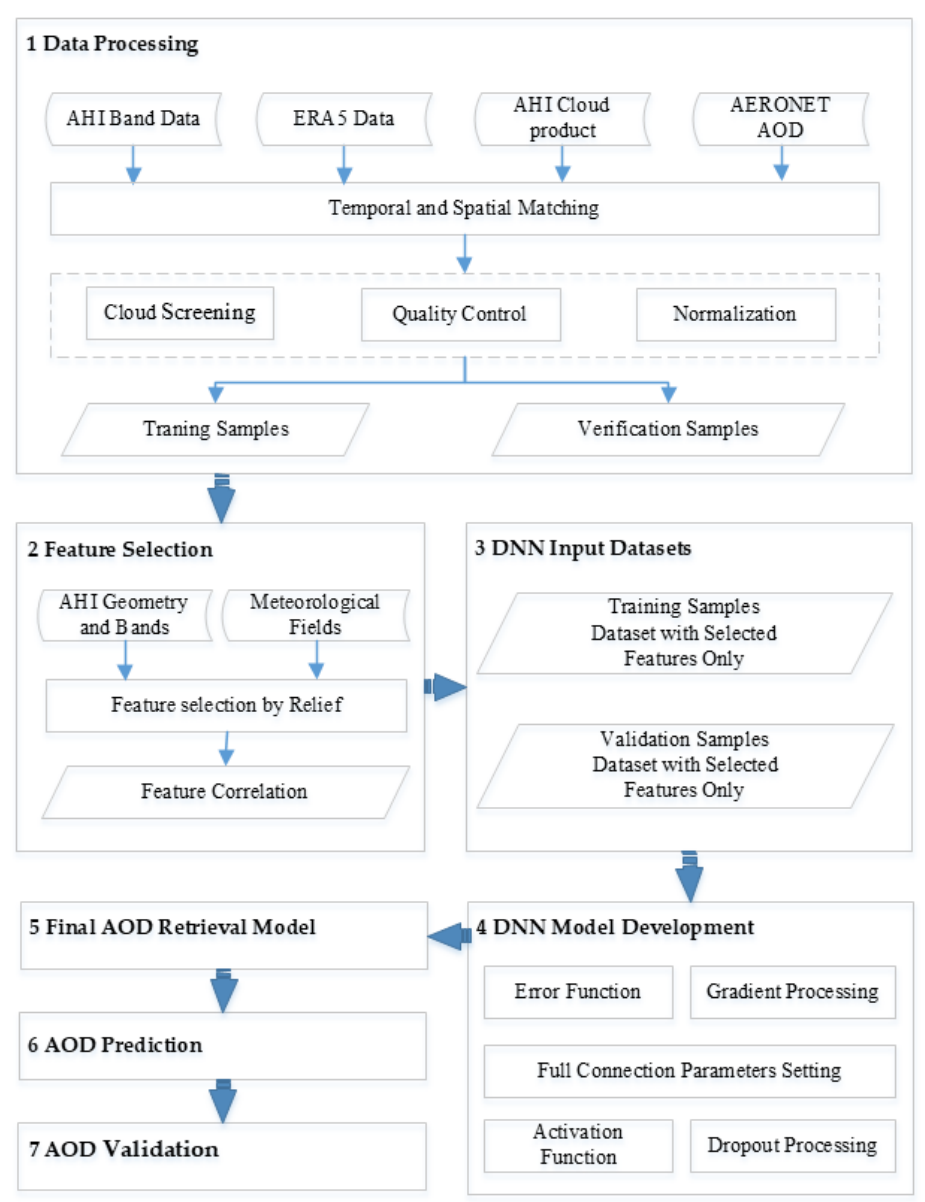
Figure 2. Flow chart of DNN model training and validation for Himawari-8/AHI AOD estimation.